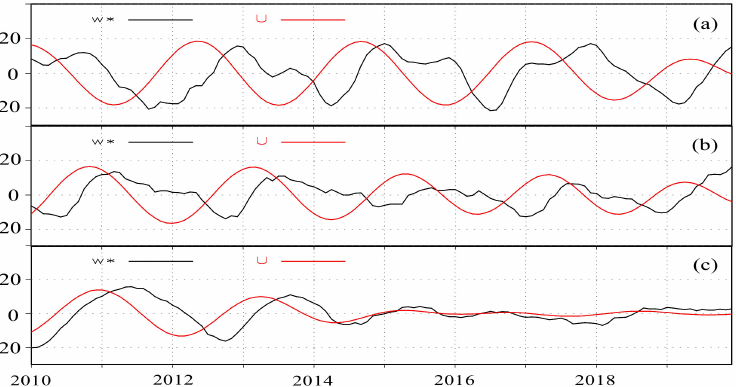
Figure 11. Zonal–mean-zonal winds (QBO components) (red) and residual mean vertical velocity anomalies (w *) (black) at 20 hPa for the ( a ) control run, perpetual runs of ( b ) January, and ( c ) April from 2010 to 2019. All of the quantities are averaged between 10 ◦ S and 10 ◦ N. Units are in ms − 1 for zonal wind and 10 − 5 ms − 1 for w